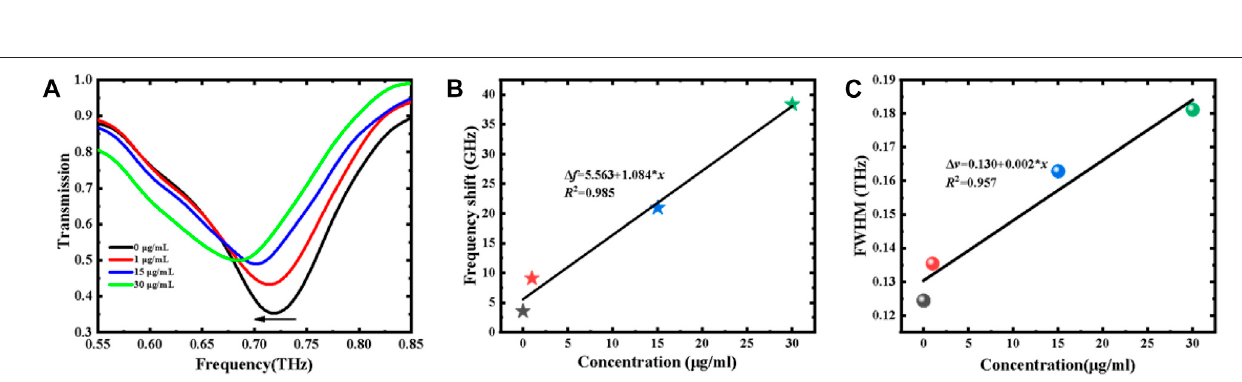
Frontiers in Physics |